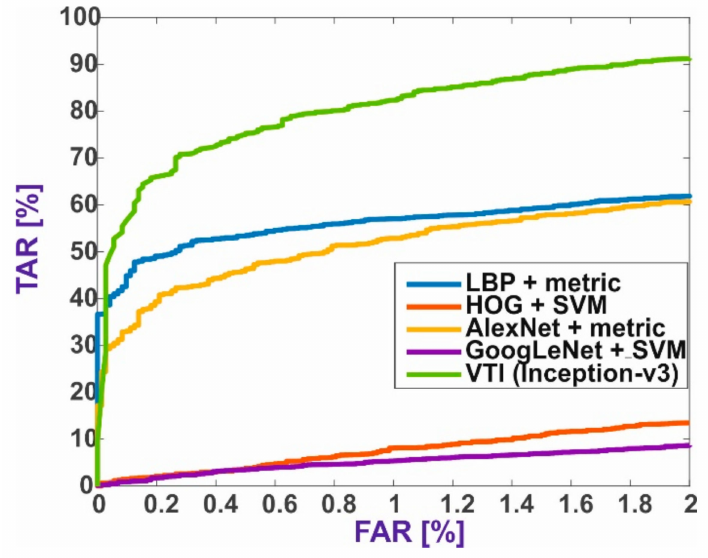
Figure 6. The best ROC curves for five face verification